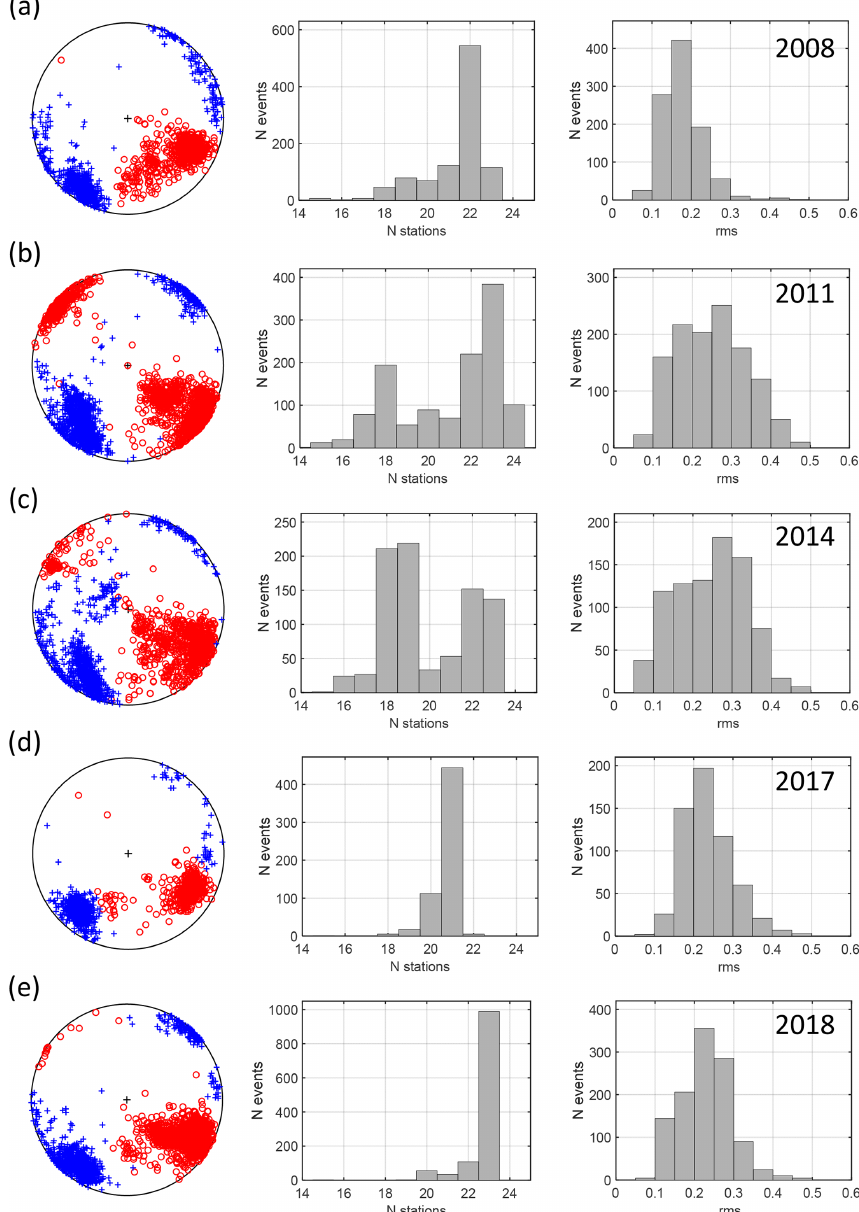
Figure 9. The P/T axes (left-hand plots), histograms of the number of stations used in the MT inversion (middle plots), and histograms of the rms of the retrieved MTs (right-hand plots) for seismic activities in 2008 (a) , 2011 (b) , 2014 (c) , 2017 (d) , and 2018 (e) . N denotes the number of stations which recorded the individual